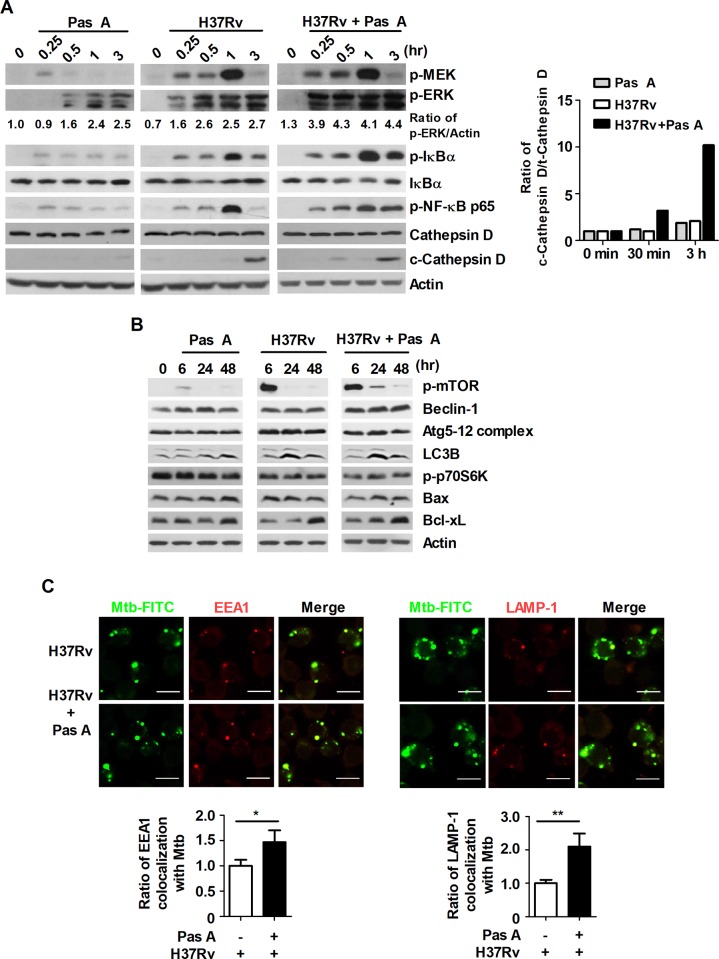
Pasakbumin A activates the NF-κB- and ERK1/2-mediated signaling pathways and induces autophagy in Mtb-infected macrophages.Raw264.7 macrophages were infected with H37Rv (at a MOI of 5), and then treated with pasakbumin A (Pas A, 10 μM) for the indicated time points. Western blot analysis showed the expression for various proteins of (A) the NF-κB, MAPK signaling pathways and (B) the expression of apoptosis- and autophagy-related proteins in pasakbumin A-treated macrophages during H37Rv infection. The band intensity was quantified, and the ratio of p-ERK, LC3-II and cleaved cathepsin D band intensity was shown in bottom of the blot. (C) Raw264.7 cells were infected with FITC-labeled H37Rv, and then treated with pasakbumin A (Pas A, 10 μM) for 3 h. The colocalization of FITC-labeled Mtb and EEA1 or LAMP-1 was monitored by confocal microscopy. Bar graphs represent as fold of change over FITC-labeled Mtb infected cells to indicate the number of FITC-labeled Mtb in EEA1+ or LAMP-1+ compartment. Bar scale, 20 μM. (A) The full length of all western blots has been provided in the S2 Fig. (B) Cropped membrane from different gels was used in western blot assay.